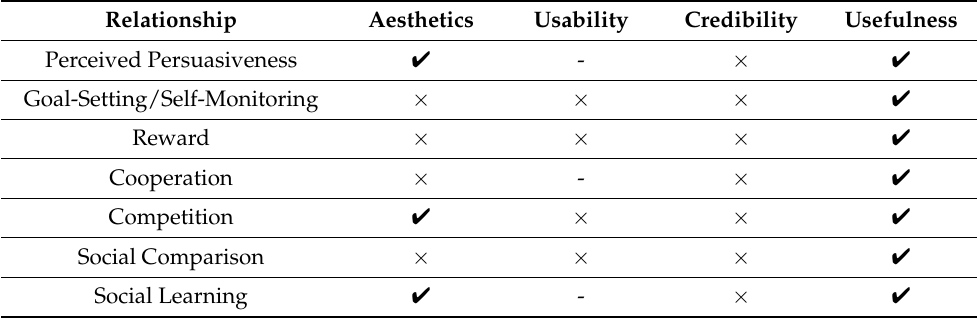
Table 7. Summary of the relationship between perceived UX design attributes and users’ receptive- ness to persuasive features. (cid:52) = positive significant relationship at p < 0.05, - = negative signiificant relationship at p < 0.05, × = non-significant relationship.